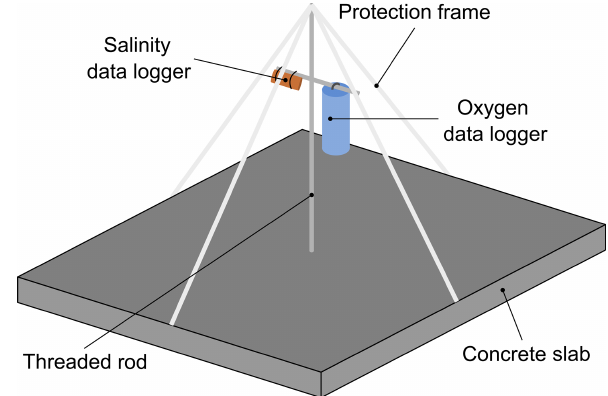
Figure 2. Scheme of deployed logger